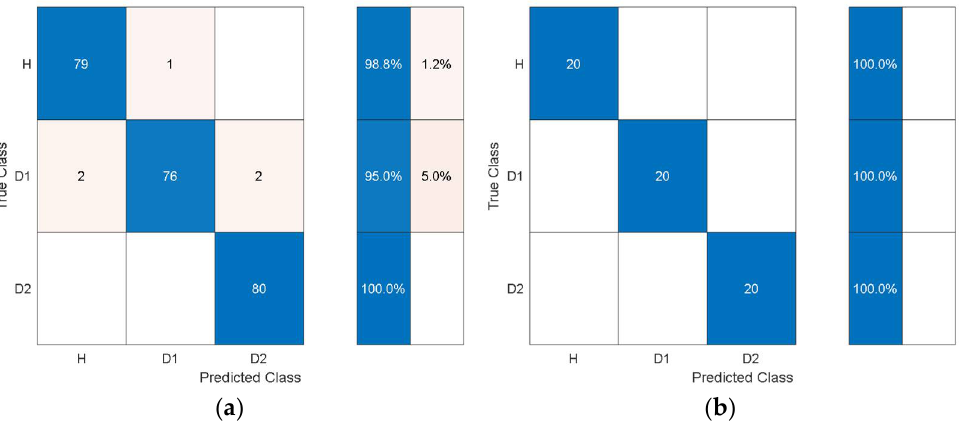
Figure 14. Classification performance of SVM using the autonomous features form the 23rd layer of AlexNet in terms of its confusion matrices: ( a ) training; ( b ) test.